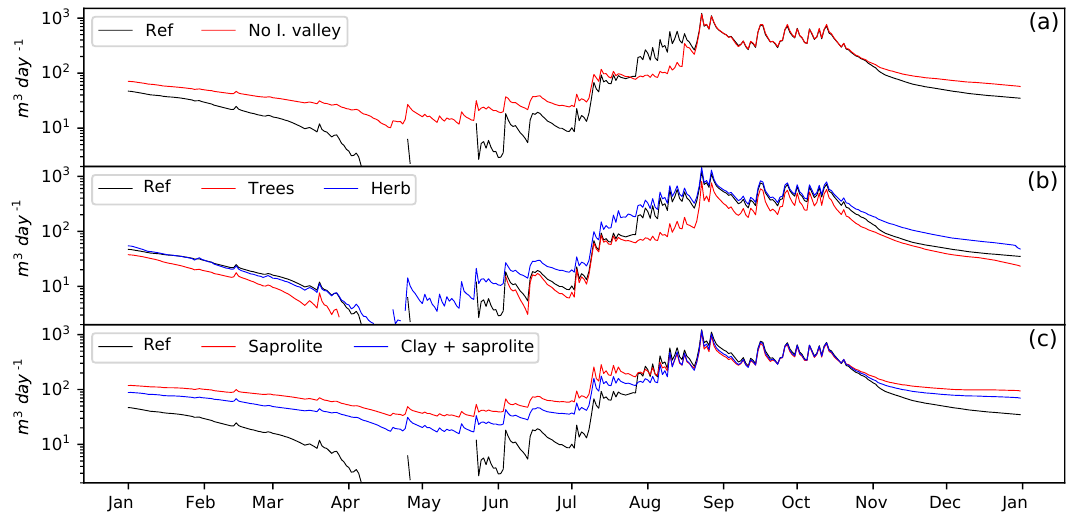
Figure 9. Simulated streamflow of year 2011 for the three virtual experiments. The reference run is always displayed as a black line. In the lower panel, the clay + saprolite refers to the “mixed” case where the H3 layer is made of clayey material on the left bank and saprolite material on the right